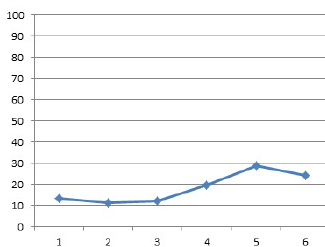
Figure 2. Spectral pattern of barren land in OLI image data. Vertical axis shows reflectance values and horizontal axis shows OLI reflective band number